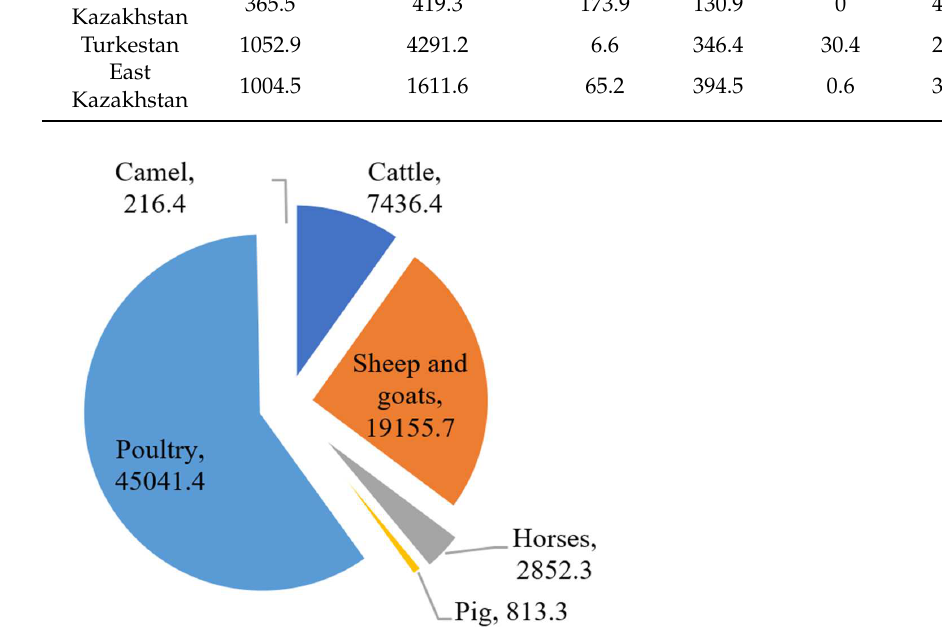
Figure 2. The numbers of livestock and poultry in Kazakhstan at the end of 2019 (thousands) [52].